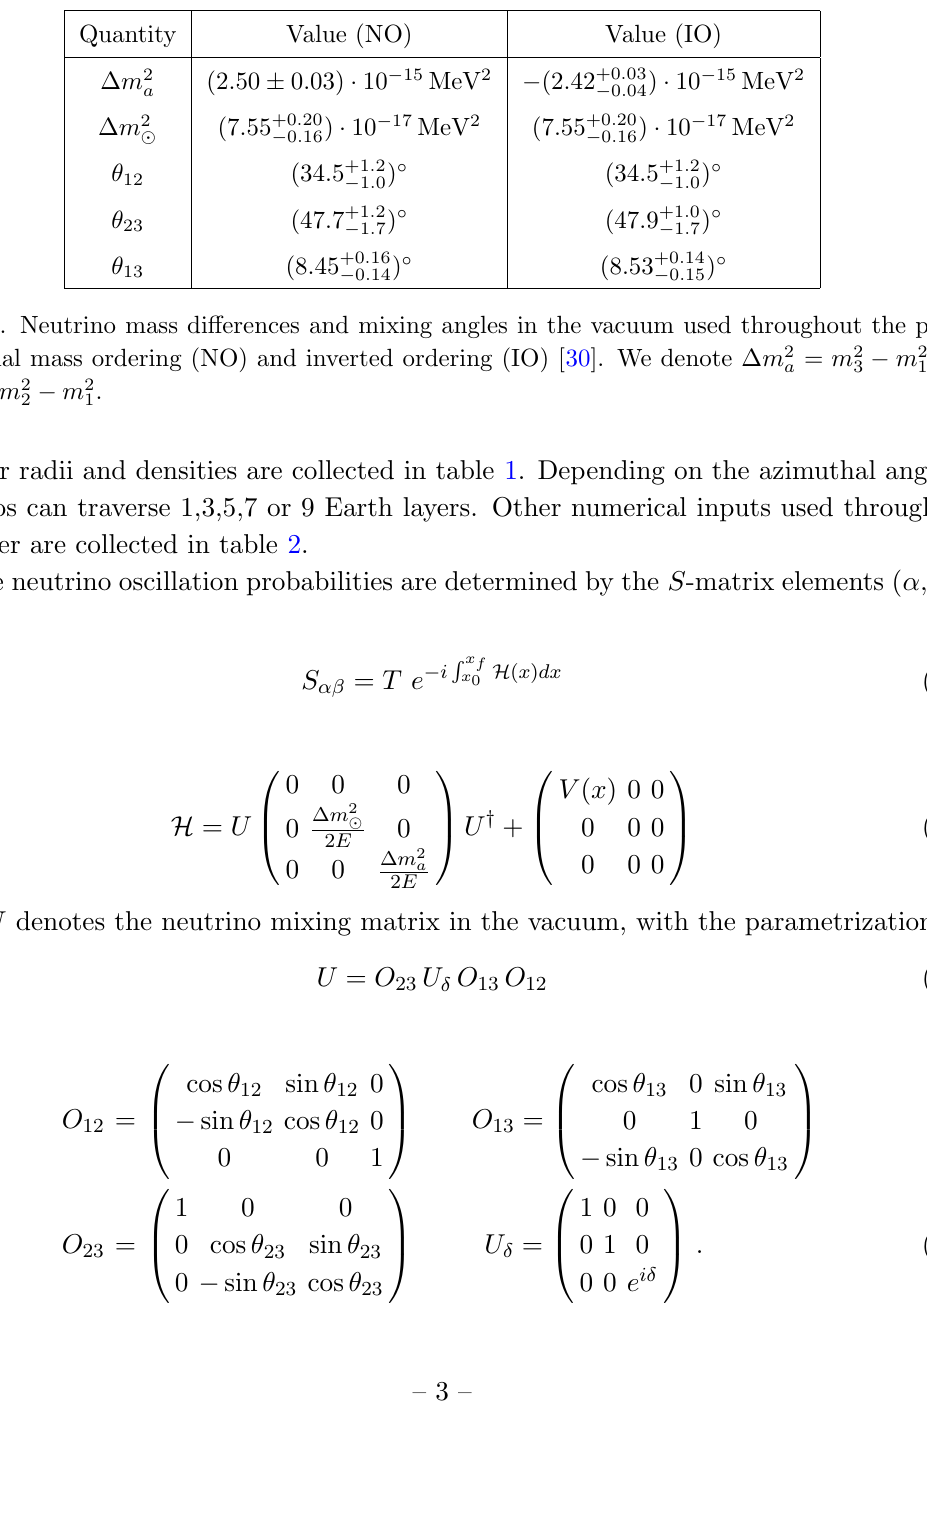
Table 1 . External layer radii as a fraction of the Earth radius R = 6371 km, average layer densities and corresponding neutrino interaction potential.